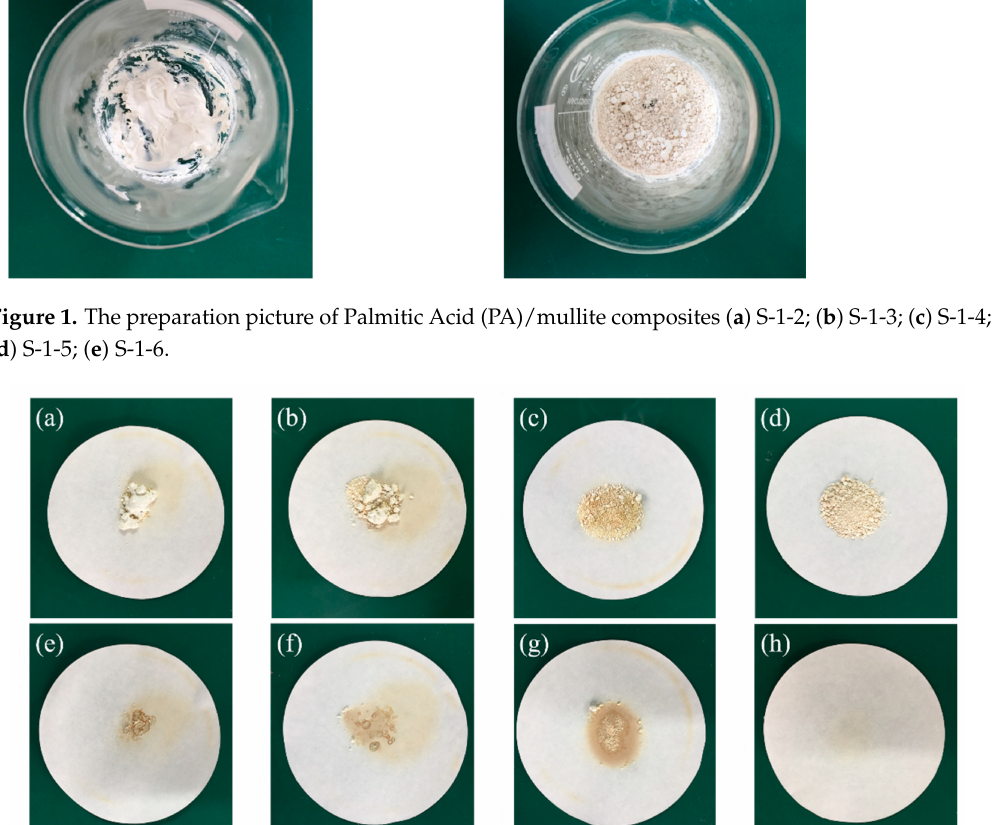
Figure 2. The leakage test of the PA/mullite composite: ( a – d ) the heating process; ( e – h ) the imprint left in the filter paper.